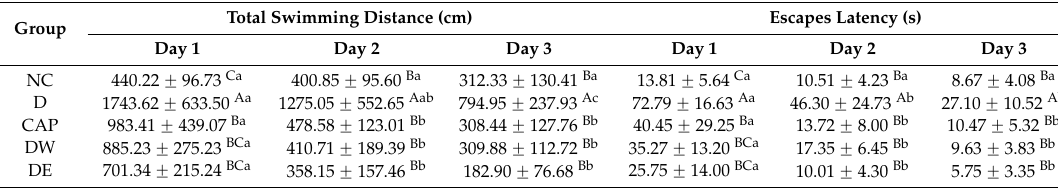
Table 3. Effects of administration of the extracts from TWK10-fermented soymilk on reference memory task in Morris water maze in DOCA-salt induced hypertension and its associated dementia rats.